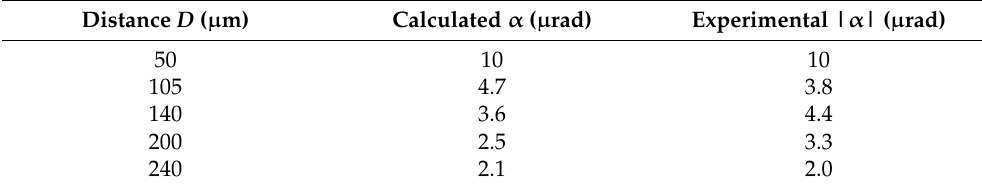
Table 1. Reported α values for different distance D, as measured in Figure 3 and as calculated by the formula in the text.